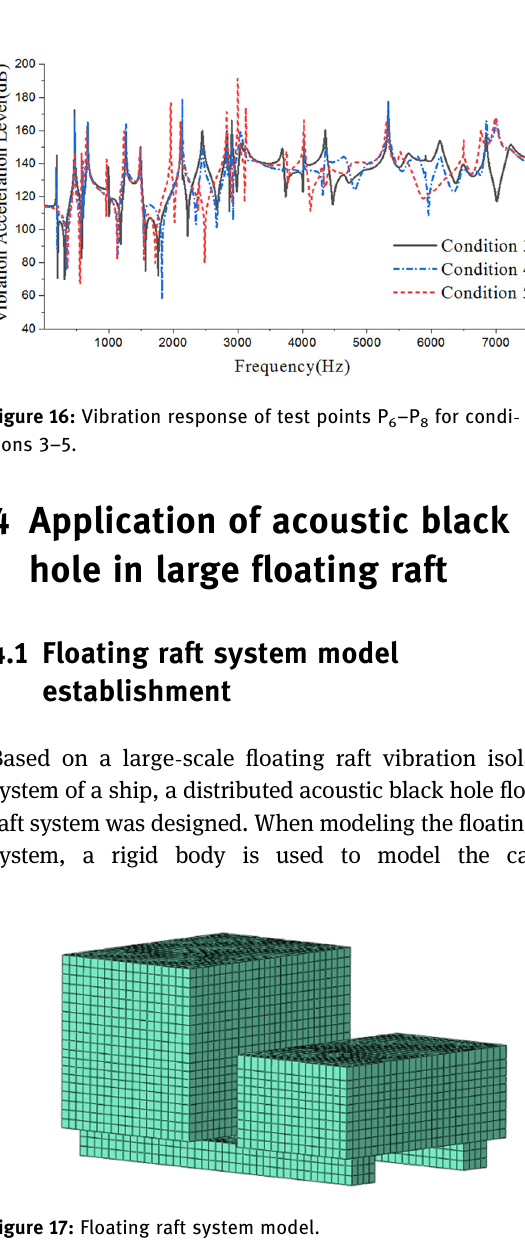
Figure 15: Vibration response of test points P 1 – P 5 for conditions 3 – 5.